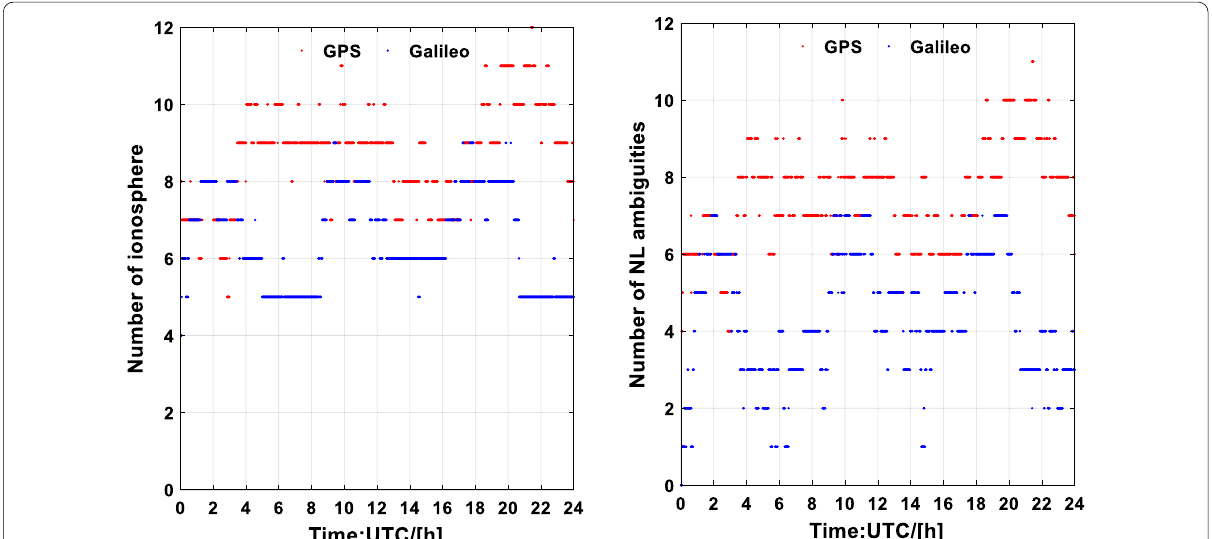
Fig. 12 Number of fixed SD NL ambiguities and the number of estimated ionospheric delays from MNMR station on DOY 082, 2021